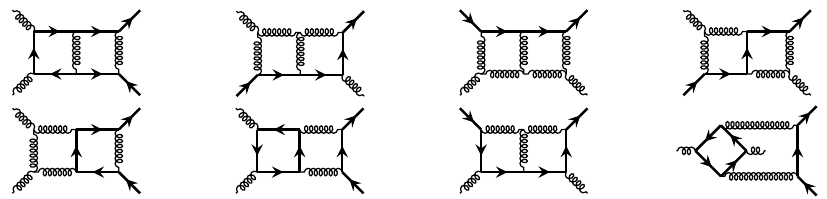
Figure 4. Two-loop masters with two external vector and matter